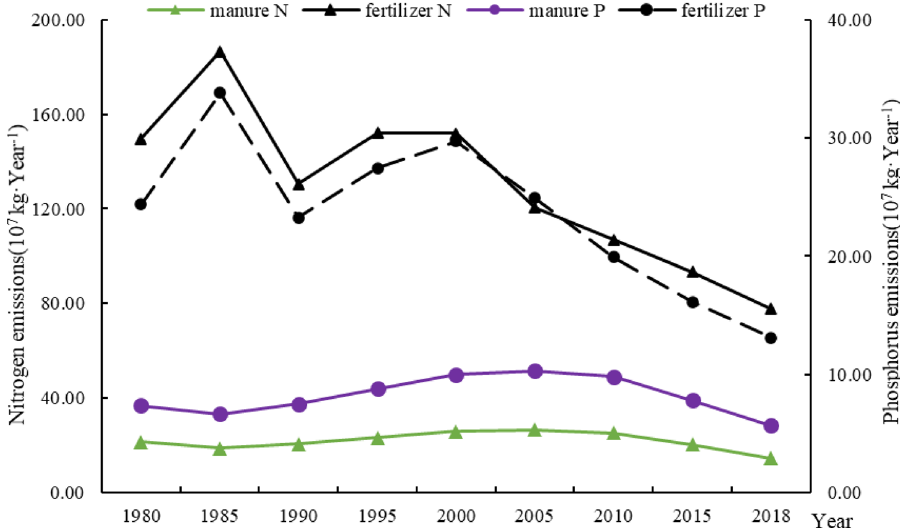
Figure 1. Application of N and P fertilizers and the amount of N and P emissions from organic fertilizers (manure) in the Yangtze River Delta from 1980 to 2018.